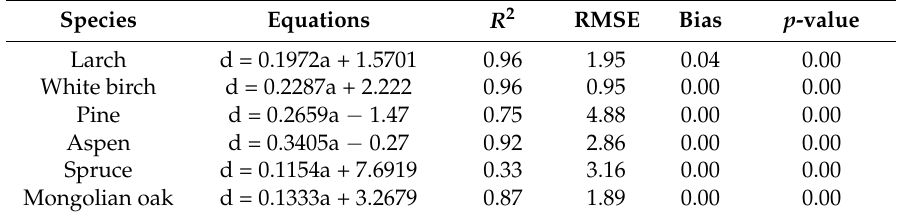
Table 1. Equations of DBH (d, unit: cm) and age (a, unit: year) for six species and accuracy assessment using leave-one-out cross validation (LOOCV). RMSE: Root mean square